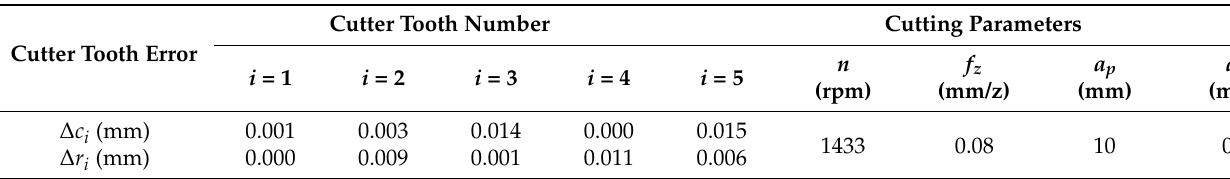
Table 1. Milling scheme and cutter tooth error distribution.